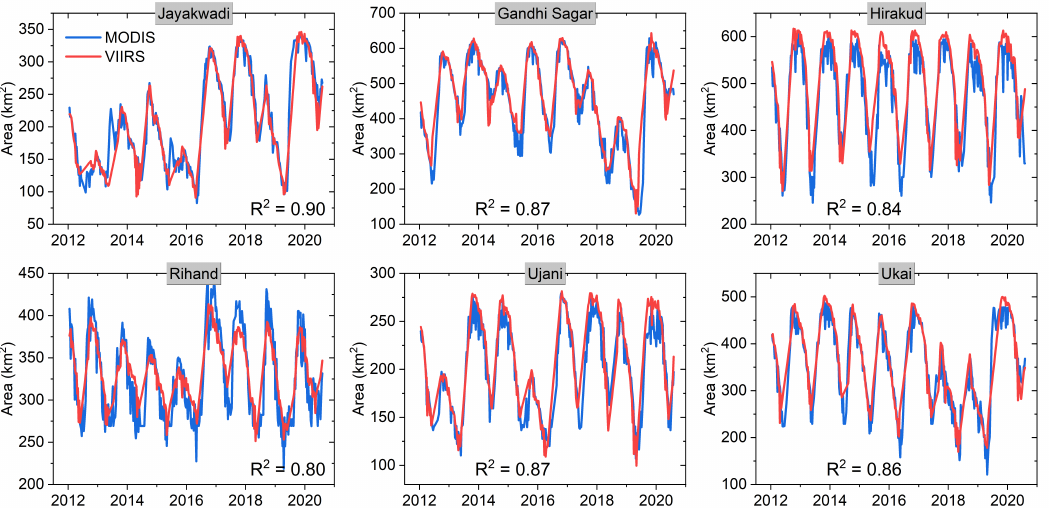
Figure 9. Comparison of 8-day area values between MODIS and Visible Infrared Imaging Radiometer Suite (VIIRS) from January 2012 to August 2020.